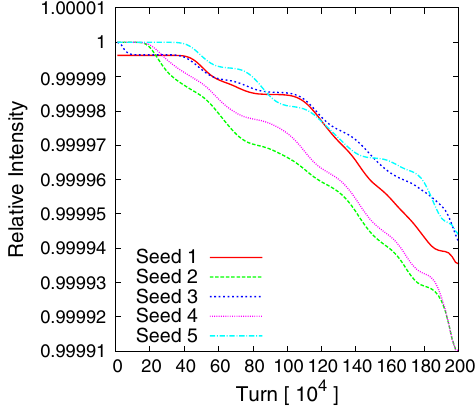
FIG. 18. Relative proton beam losses in 2 (cid:2) 10 6 turns for the proton bunch intensity 2 : 5 (cid:2) 10 11 without beam-beam compen- sation, with half beam-beam compensation, with the betatron phase advance adjustment, and with the global second order chromaticity correction.